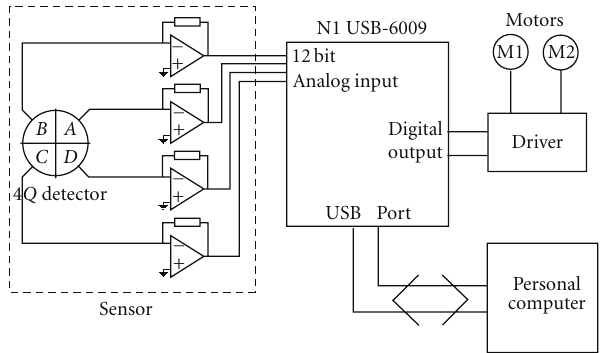
Figure 7: Scheme of the electronics.